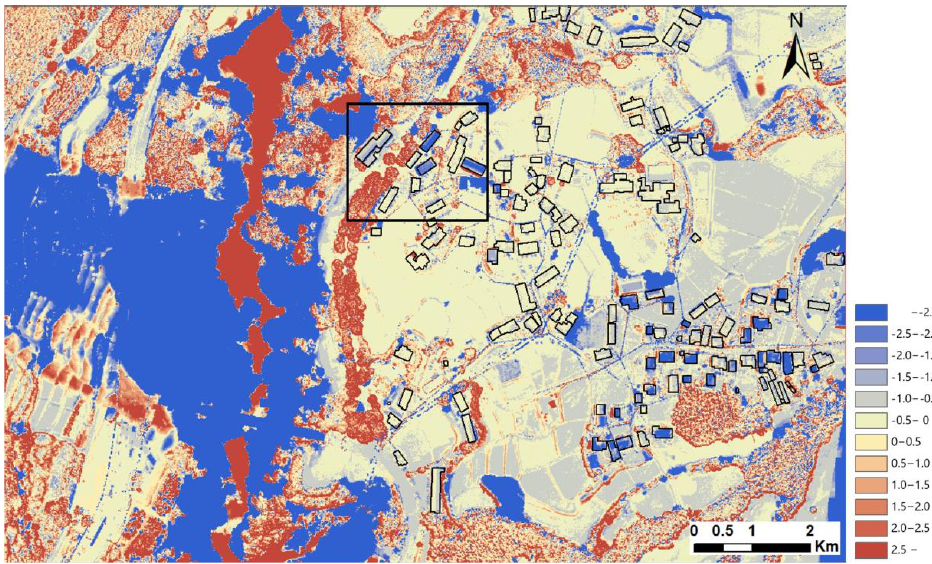
Figure 6. DSM difference in the co-event period (2013.1–2016.4) for Kawayo district with building footprints [40]. In the black square, three apartment buildings had totally collapsed.